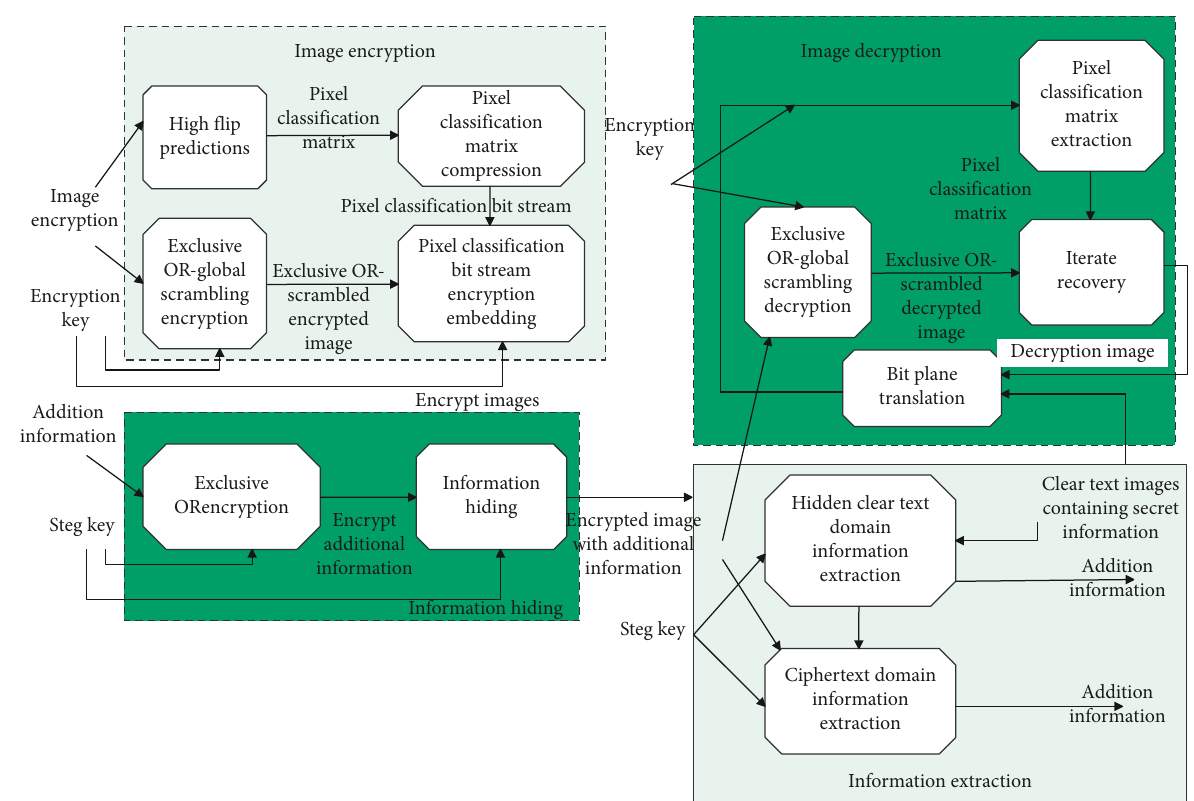
Figure 6: Astructure block diagram of image reversible information hiding